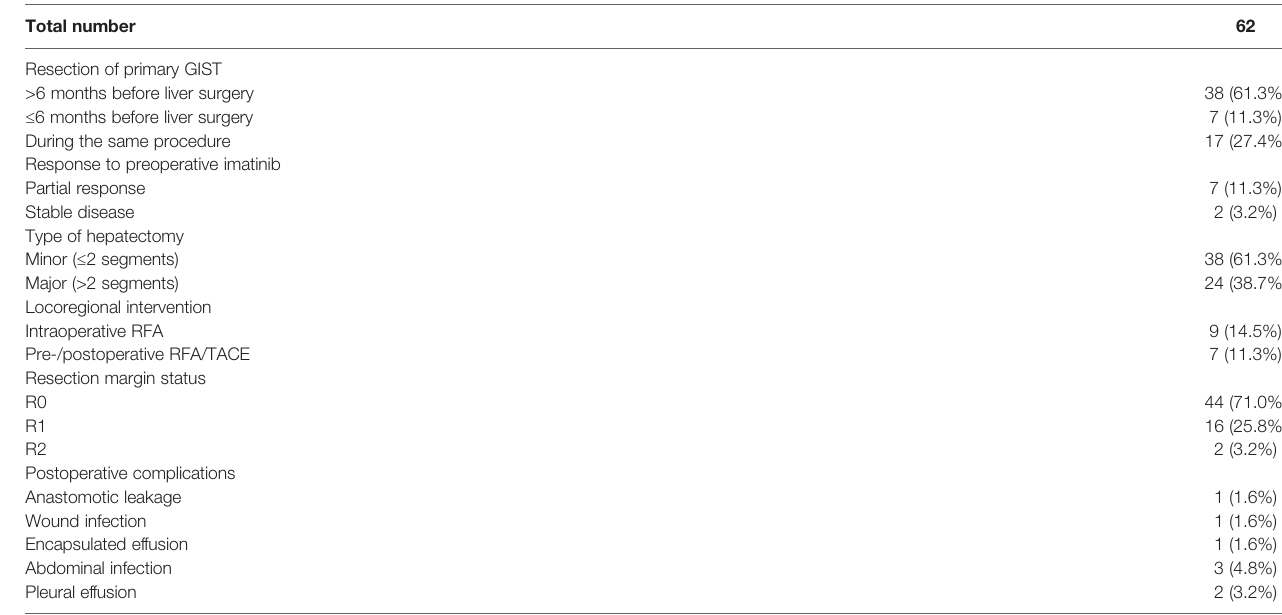
TABLE 2 | Surgical treatments and